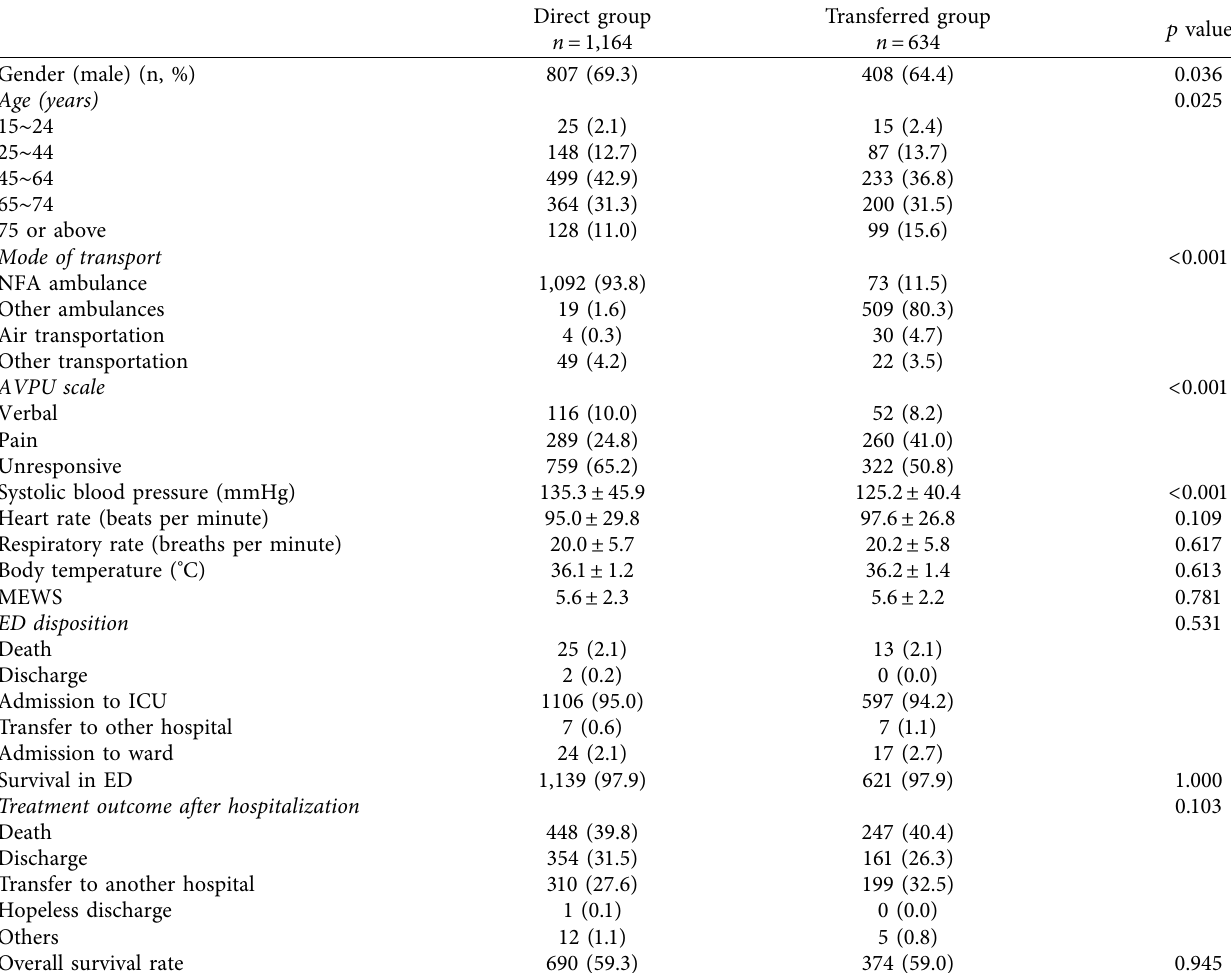
Table 2: Characteristics of patients who received therapeutic hypothermia in the emergency medical centers, either in the emergency departments or after hospitalization. Those who were transported directly and those who were transferred from other hospitals were compared. Values are reported in counts and percentages in parentheses.